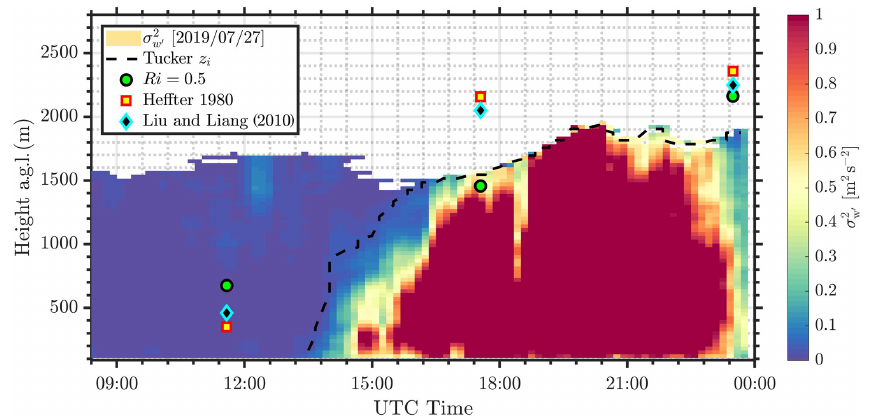
Figure 2. Typical CBL showing lidar variance (colours), Tucker z i (black line), and radiosonde z i (three methods; symbols). The horizontal axis shows the number of hours after 00:00UTC on 27 July 2019.